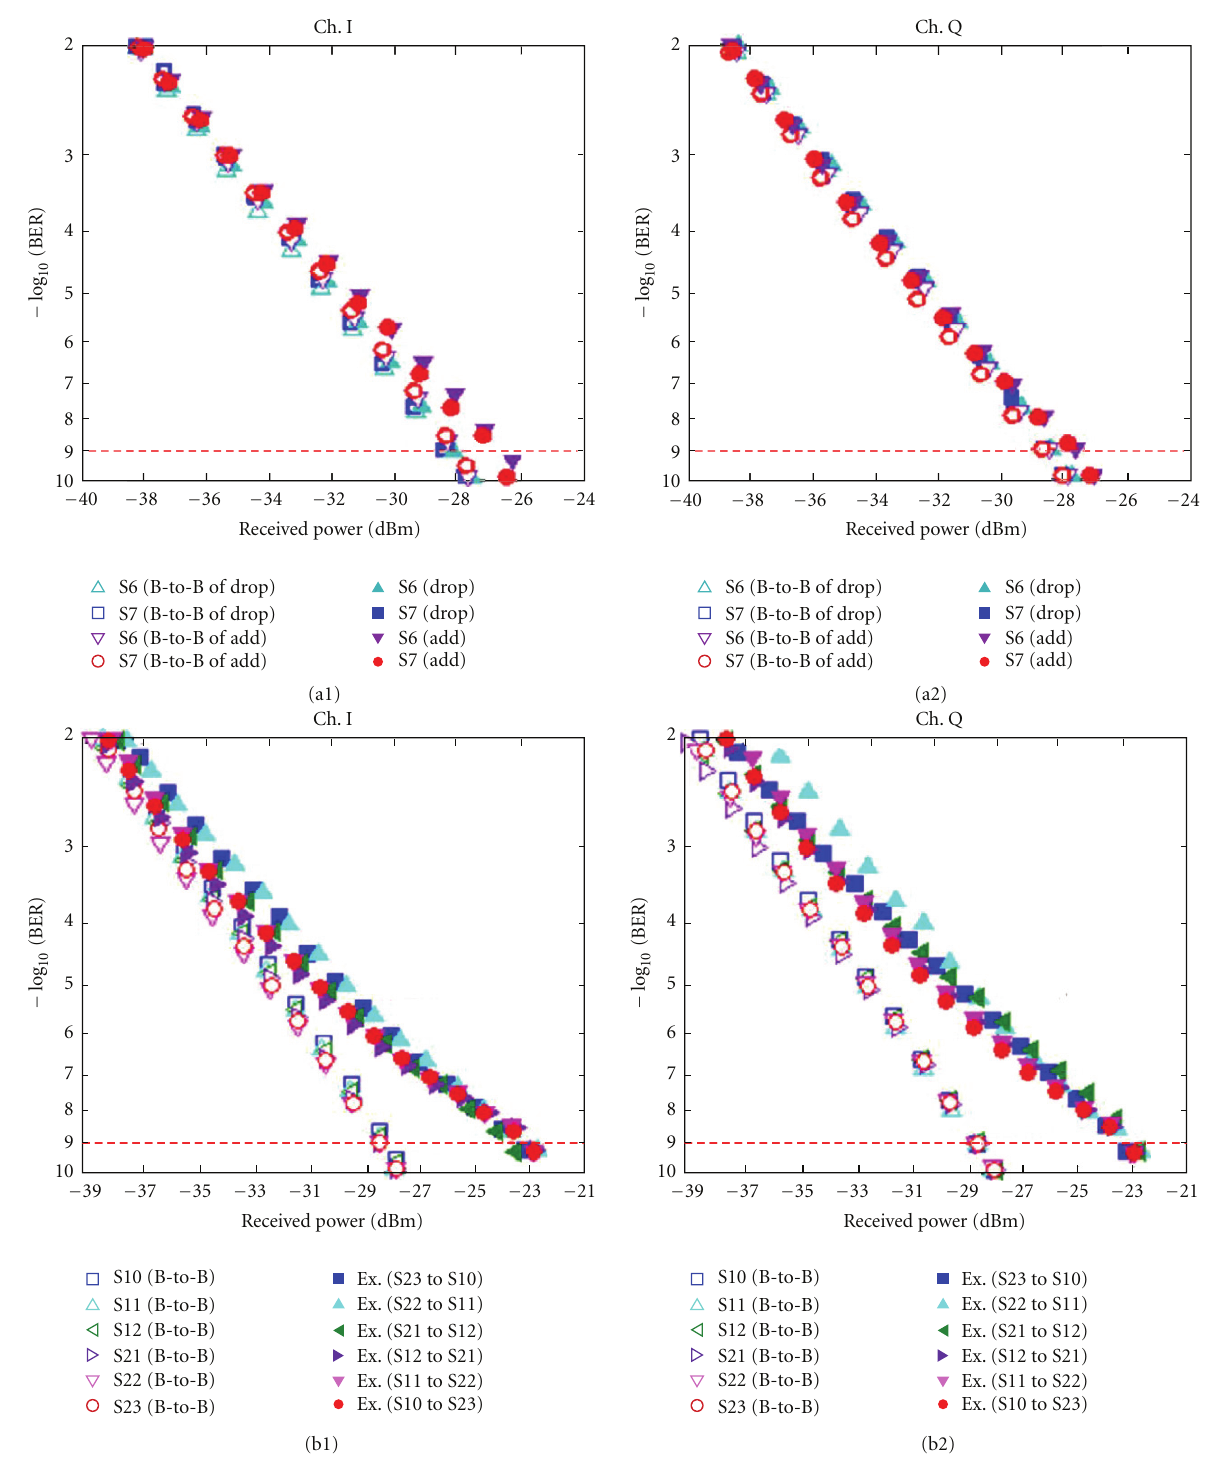
Figure 28: BER curves for (a1 and a2) two-channel add/drop (S6, S7) and (b1 and b2) simultaneous six-channel data exchange (S10, S11, S12, S21, S22,